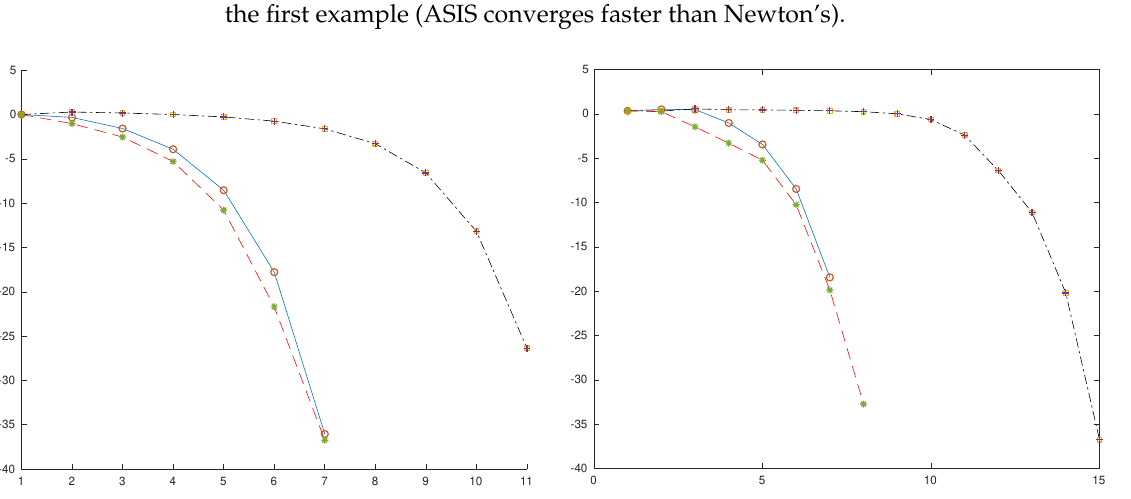
Figure 1. Logarithms of errors: Newton, blue solid line, red ‘o’; Steffensen, black ‘.-.’, red ‘+’; ASIS, red ‘–’, green ‘*’. Example 1 (scalar) ( left ); Example 3 (system) ( right